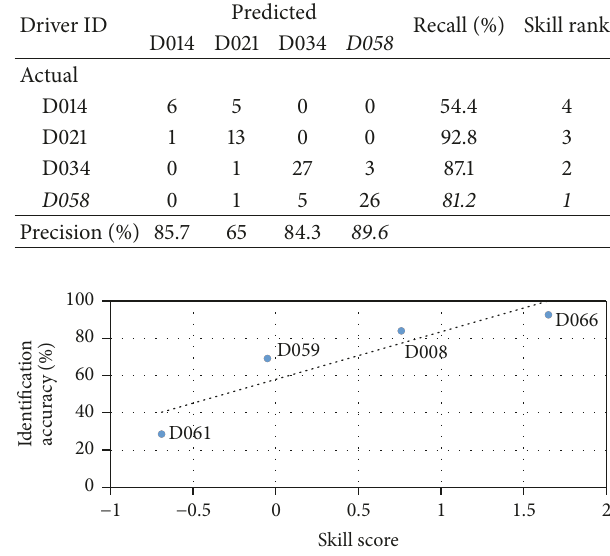
Figure 5: Identification accuracy obtained in a group with identical aggression displayed by the